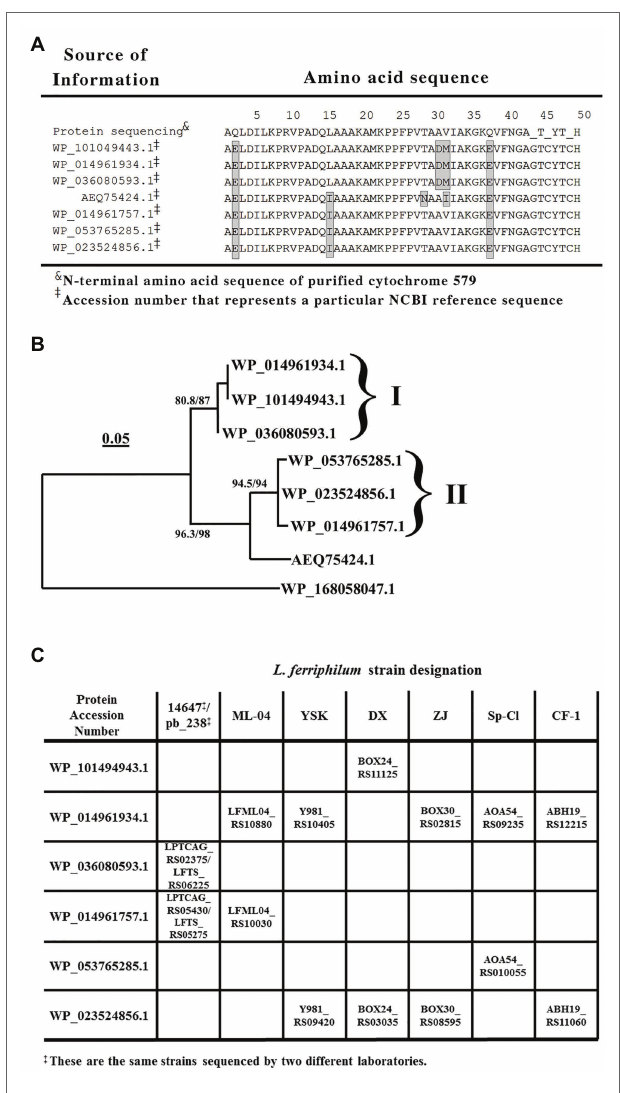
FIGURE 3 | Sequence comparisons of cytochromes 579 that could be expressed in different strains of L. ferriphilum . (A) Alignment of amino acid sequences obtained from either the N-terminal amino acid sequencing of cytochrome 579 purified from the type strain of L. ferriphilum or from tBLASTn searches of the genomes of purified strains of L. ferriphilum that are contained in the NCBI database. The amino acids within each shaded rectangle are those that differ from the corresponding amino acids determined in the protein sequencing data presented herein. Beyond amino acid number 40, the individual amino acid peaks in each round of the sequencing became sufficiently small and irregular so as to prevent a confident identification of the amino acid released during each round of degradation. (B) A rooted phylogenetic tree based on seven cytochrome 579 amino acid sequences taken from the proteins represented by the accession numbers shown in (A) . The outlying sequence (lowermost item shown in the figure) represents a monoheme c -type cytochrome of similar length present in the genomic sequence of Candidatus Manganitrophus noduliformans . The tree was inferred using the maximum likelihood method with 1,000 replicates. The brackets and Roman numerals identify the two groups of cytochromes 579 that possess different N-terminal signal peptide sequences. (C) Identities and genetic loci of the two proteins in each strain of L. ferriphilum that bear a high level of sequence homology with the cytochrome 579 purified from the type strain of L. ferriphilum . The genetic loci within each rectangle were obtained from the tBLASTn searches conducted on each